Question: Give a one-sentence summary of this figure.
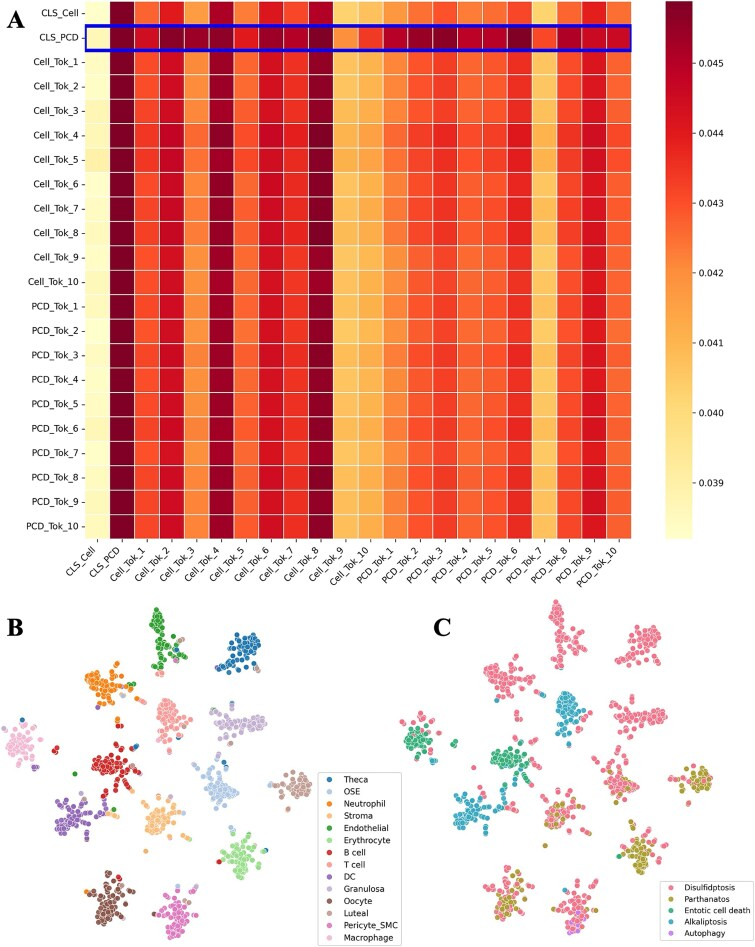
Answer: Interpretability of DeepMCD latent interactions. (A) Cross-task attention heatmap extracted from the final transformer layer, demonstrating the explicit querying of cell-type tokens by the [CLS_PCD] token. T-SNE visualization of the [CLS_PCD] latent space aligned by (B) predominant cell lineages and (C) dominant cell death pathways, revealing biologically structured topological clusters.